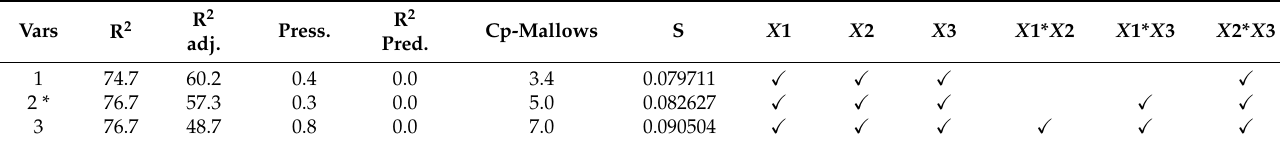
Table 5. Results of best-subset analysis search from MINITAB© for Y 1, comparing the prior model augmented with two ways interactions. Selected choice marked with “*”.